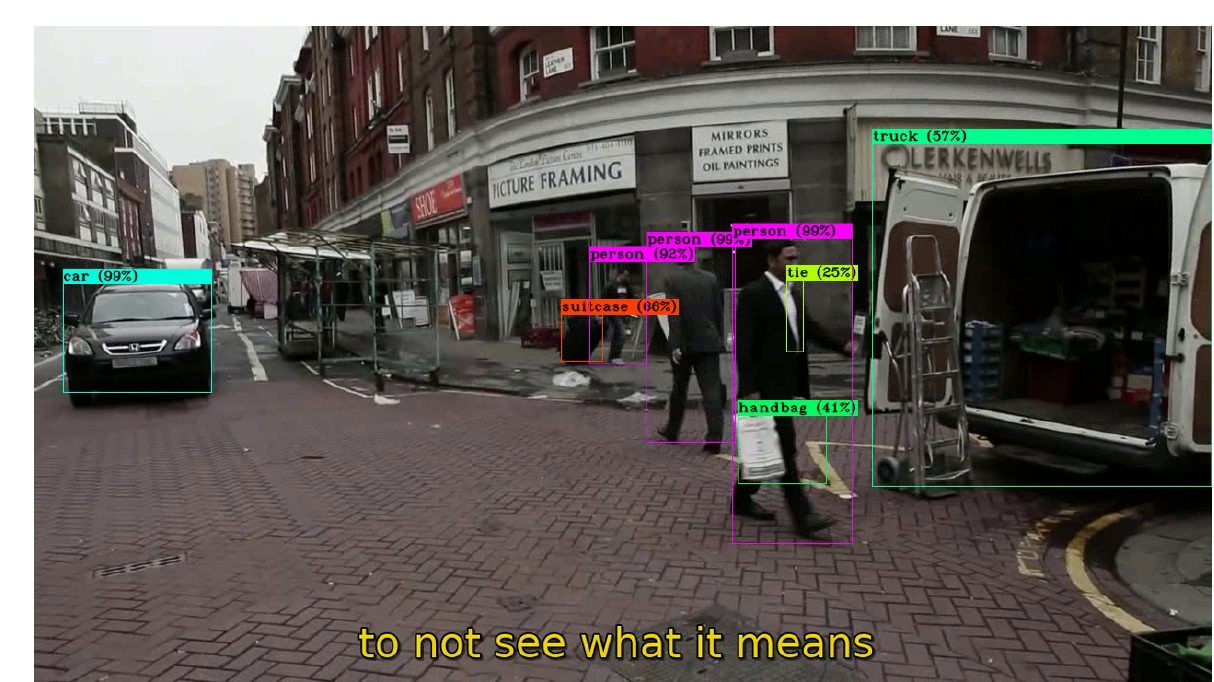
Figure 4. Snapshot of a video resulting from the object recognition function along with the automatically generated subtitles after a workflow